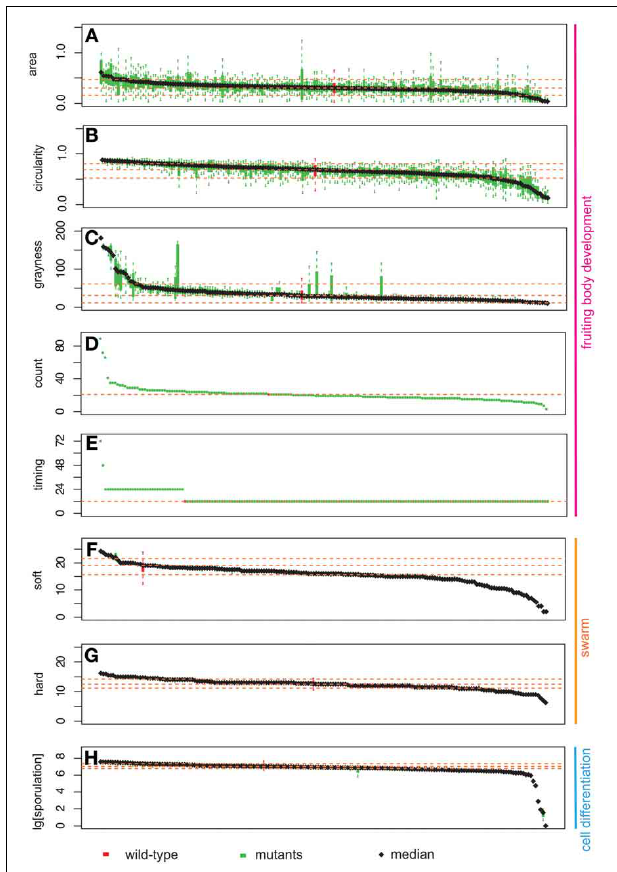
FIGURE 3 | Distribution of phenotypic data: area (A), circularity (B), grayness (C), count (D), timing (E), expansion on soft (F), and hard agar (G), and sporulation efficiency (H). The y-axis represents the measurement for each phenotypic assay. Bars on the x-axis represent 180 mutants and wild type. Green bars represent mutant strains, while red bars represent wild type. Box plots represent two middle quartiles. Error bars represent the top and bottom interquartile range for each strain. Yellow dash lines represent the mean ± SD (top, bottom), and median for wild type. In (D,E) , no error bars are present due to the nature of our measurements (for details, please see Materials and Methods).